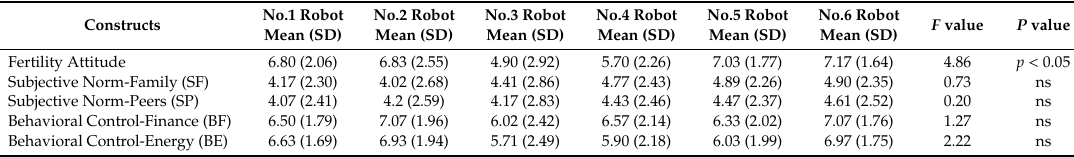
Figure 4. The relationship between fertility attitude under di ff erent stimuli. Table 5. The mean, SD, F value, P value of di ff erent variables and their